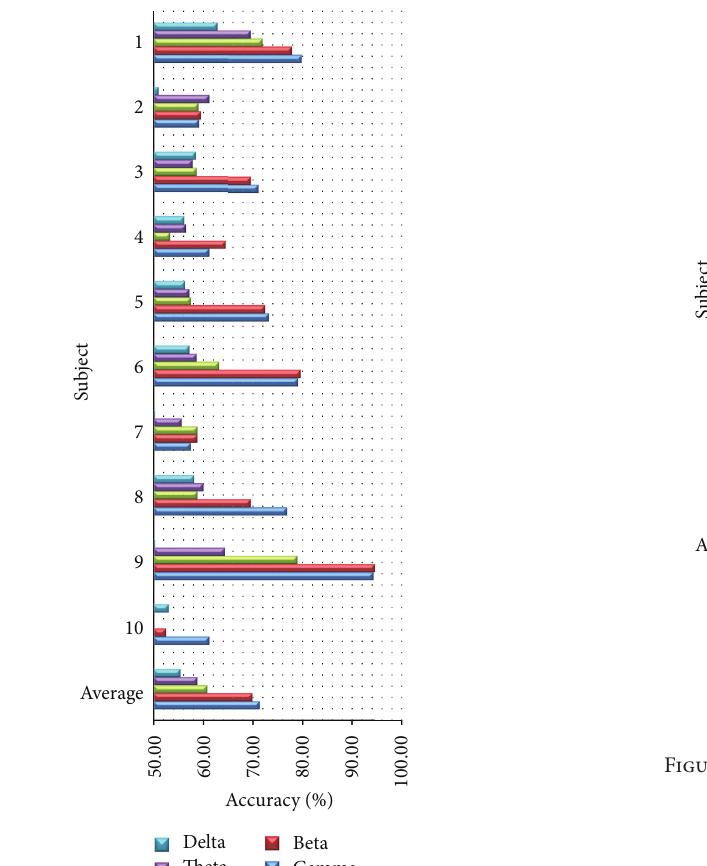
Figure 8: Accuracy from different frequency bands.